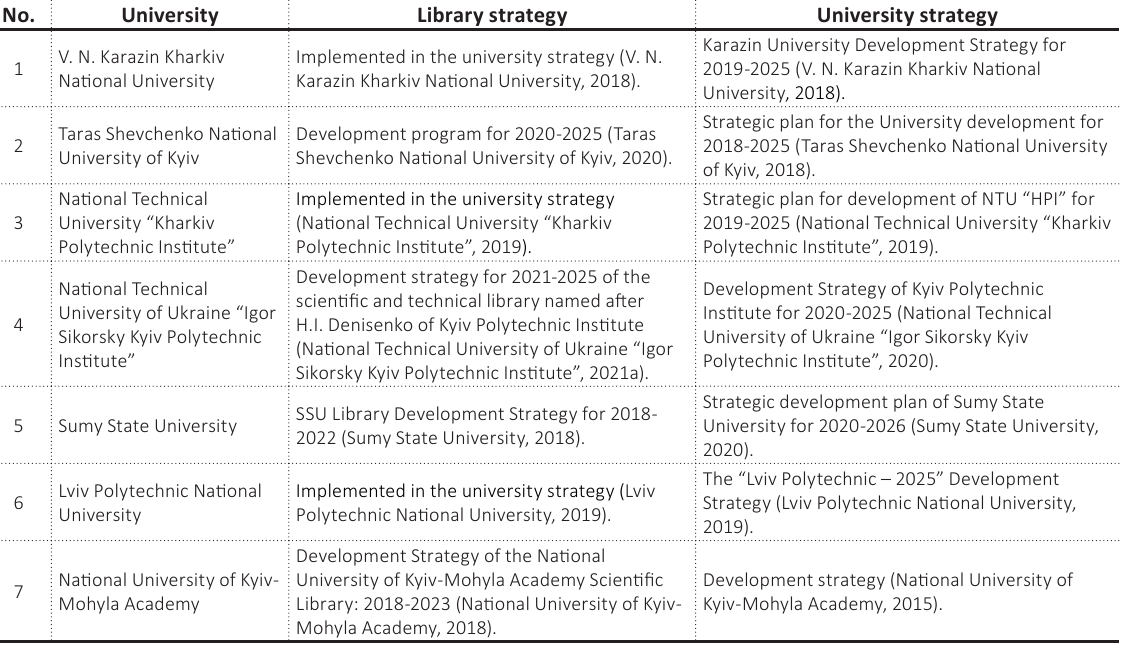
Table A1. Information about the strategies in leading universities of Ukraine and their libraries